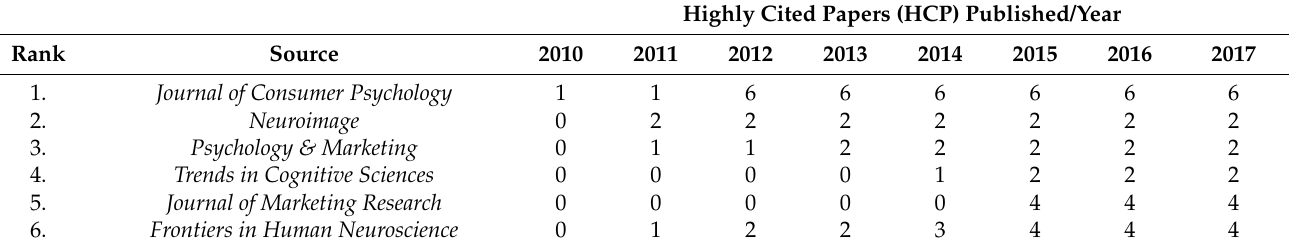
Table 8. Top 10 Most Relevant Authors and Author Local Impact.